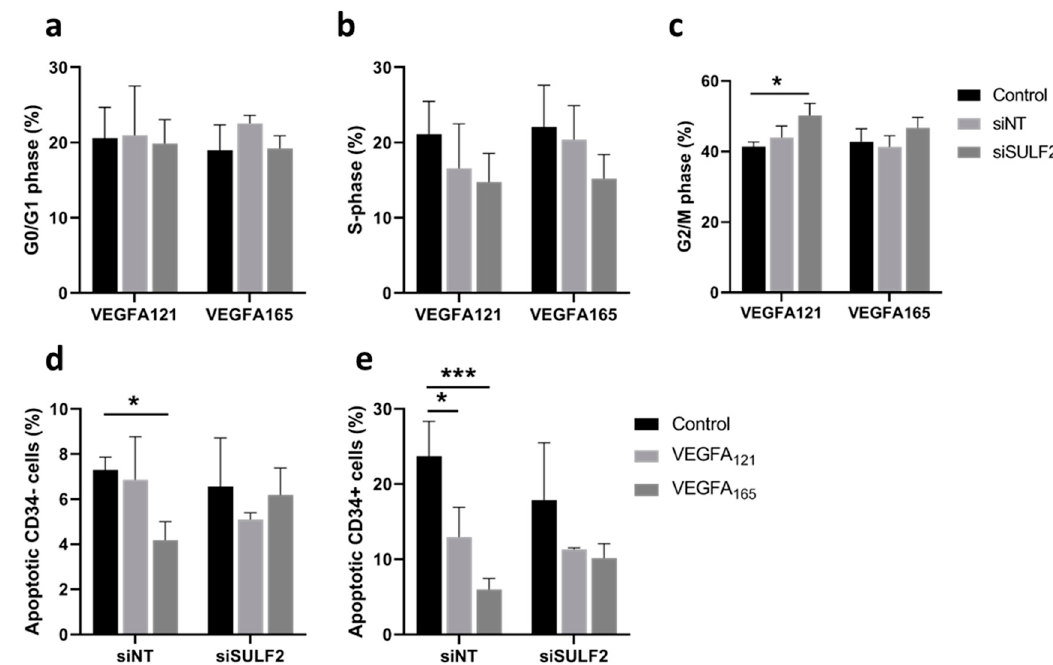
Figure 2. Effects of SULF2 knockdown on VEGFA 121 - and VEGFA 165 -induced cell proliferation and apoptosis. HUVECs were cultured in the presence or absence of VEGFA 165 , VEGF 121 or no VEGF (Control) after treatment with siNT or si SULF2 . Flow cytometric analysis determined the percentage of cells in G0/G1 phase ( a ), S-phase ( b ), and G2/M phase ( c ). FACS analysis after annexin-5 and CD34 labeling determined the percentage of CD34 - non-tip cells ( d ) and CD34 + tip cells ( e ). Results are presented as the mean ± standard deviation of three HUVEC donors. Two-way ANOVA was used to calculate statistical differences (* p < 0.05, *** p < 0.001).